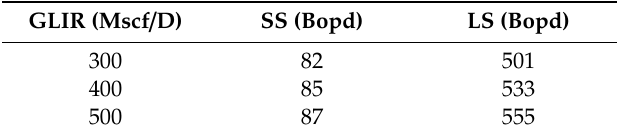
Figure 10. Gas lift performance curve for LS and SS. Table 5. GLIR sensitivity against production.